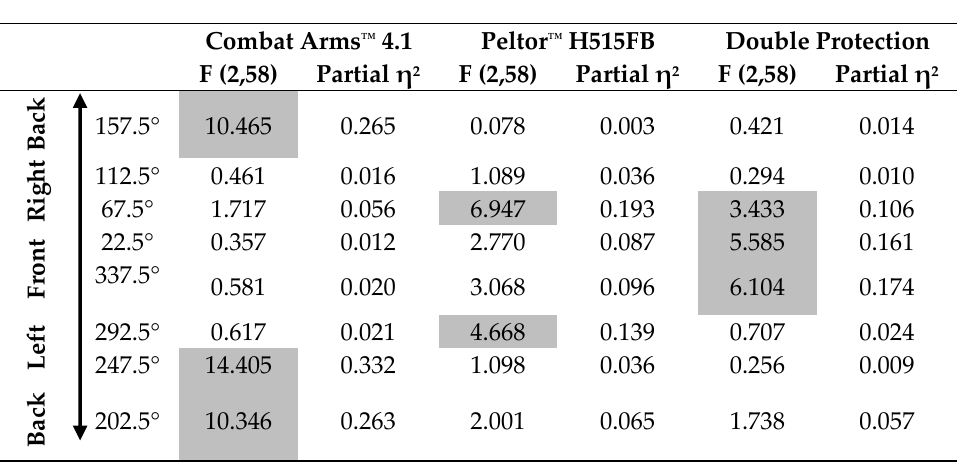
Table 3. Main effects for comparison between stimuli using different HPDs and from different source angles.